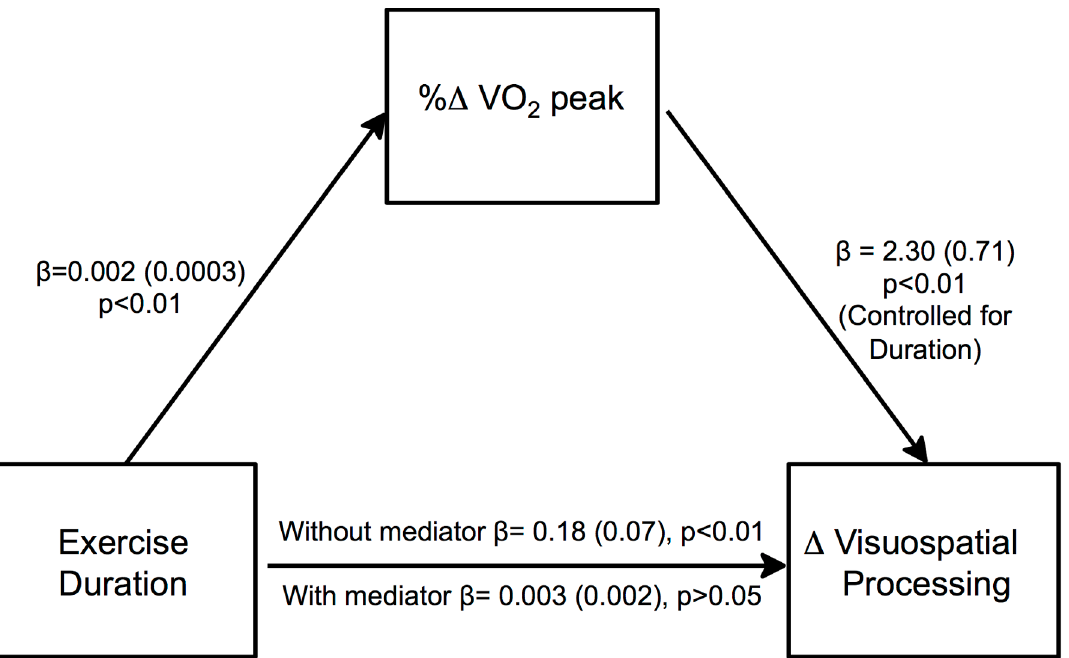
Fig 3. Cardiorespiratory fitness change mediates exercise duration effects on visuospatial performance. In the basic model without cardiorespiratory fitness change (%change in VO2 peak over 26 weeks) as a mediator, total number of minutes exercised (Exercise Duration) was associated with change in Visuospatial Processing. When change in cardiorespiratory fitness was added to the model as a potential mediator, it fully mediated the relationship of Exercise Duration and Visuospatial Processing improvement. Betas (Standard Error) are reported as the product of simultaneous regression with bootstrap